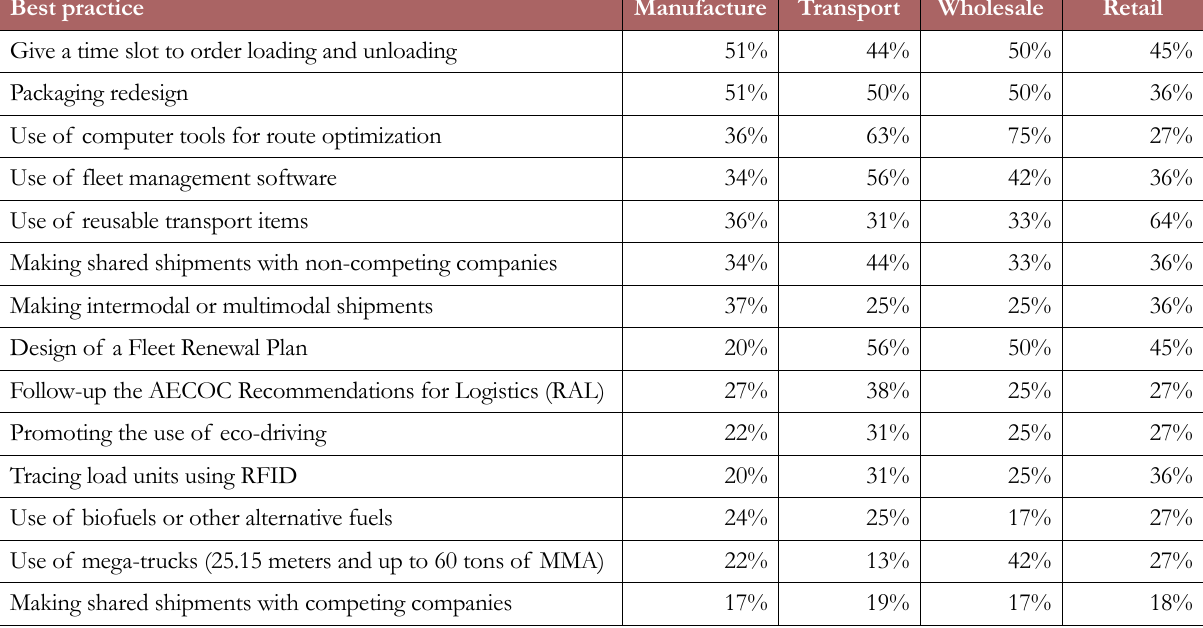
Table 1. Use of best practices by companies’ roles in the supply